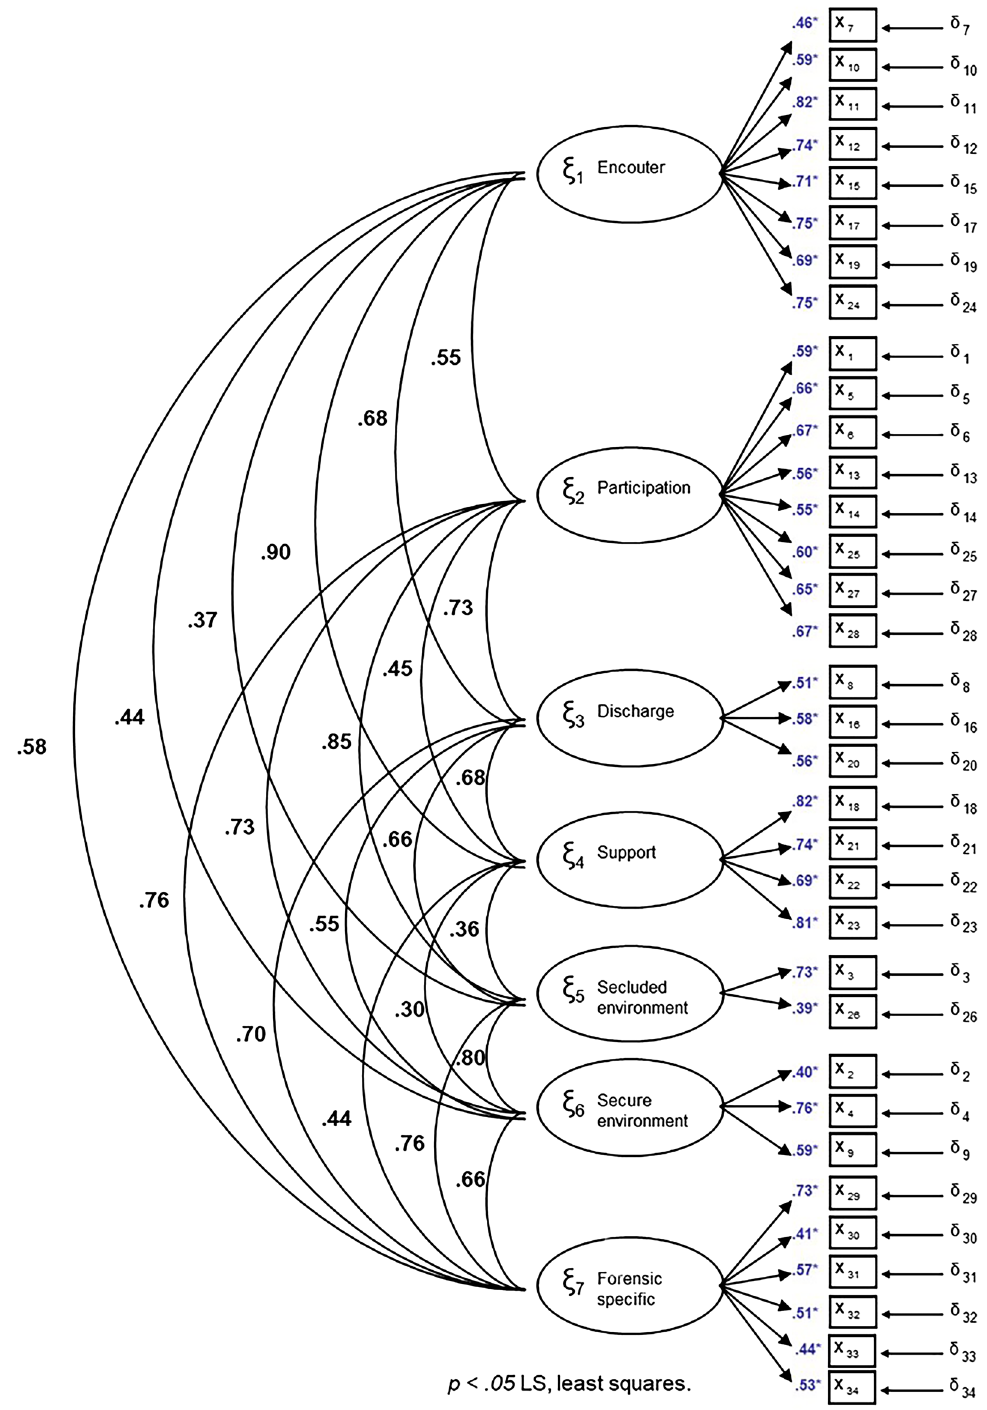
Figure 1. Factor loadings derived from the LS estimation (least